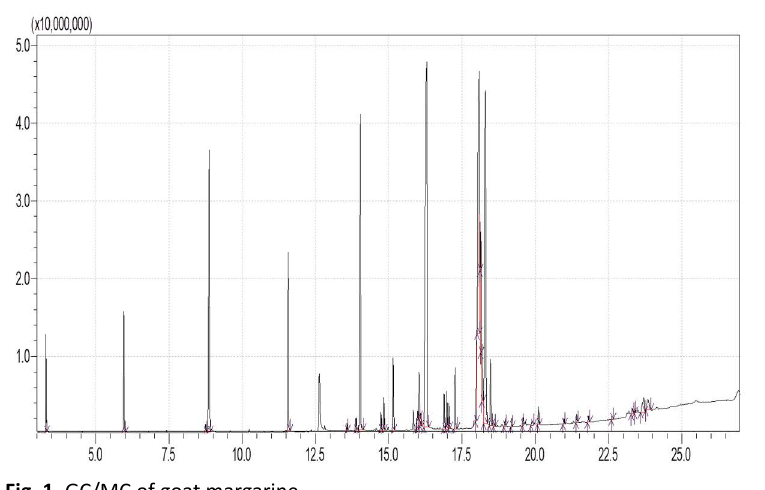
Fig. 1. GC/MC of goat margarine